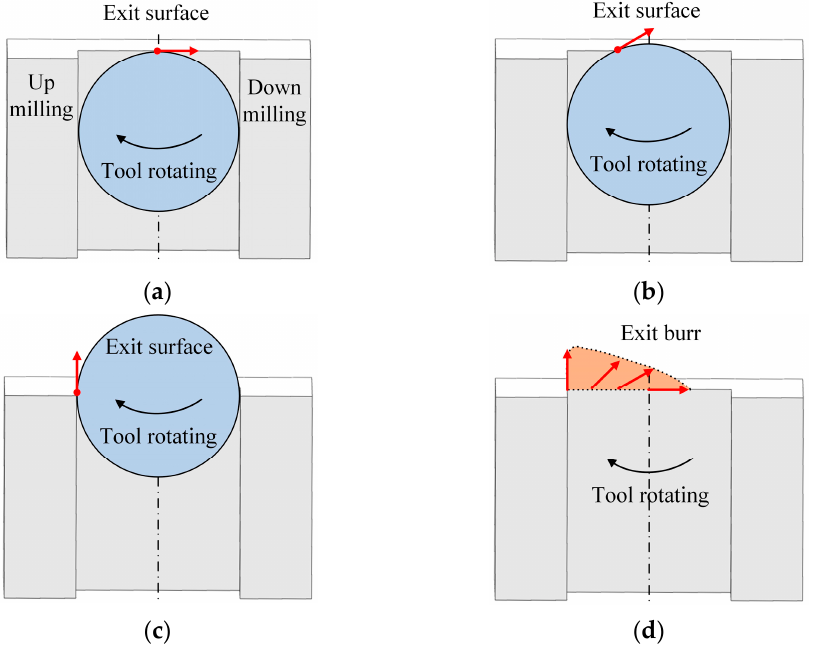
Figure 6. Exit burr growing direction in micro milling. ( a ) Parallel with exit surface. ( b ) Intersect with exit surface. ( c ) Perpendicular to exit surface. ( d ) Exit burr growing in micro milling.